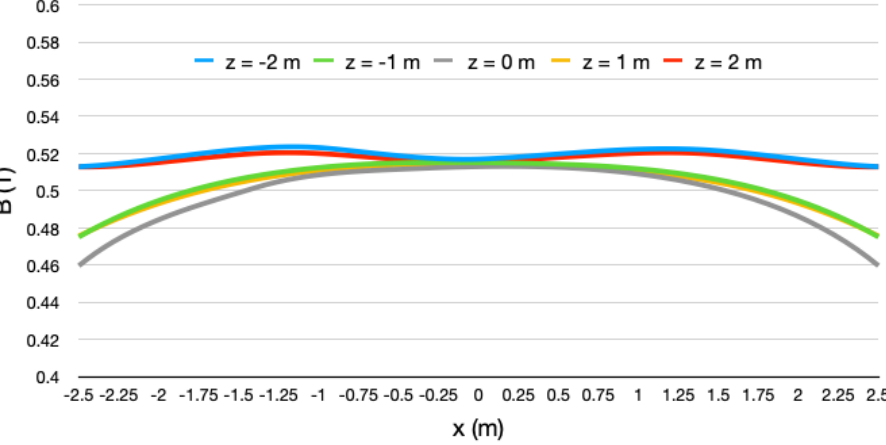
Figure 53. Field map for SPY along the axis of the solenoid ( x ). The field is shown for different positions in the horizontal plane, ranging from z = LArTPC direction. Noticeably there is a small asymmetry due to the asymmetric distribution of iron in the